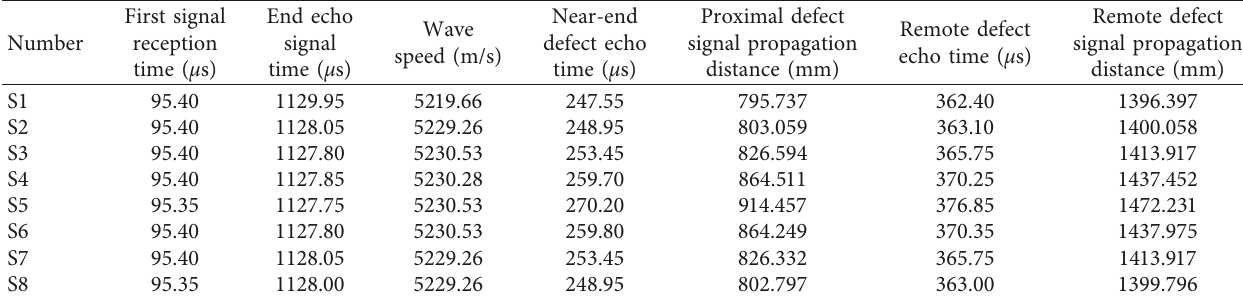
Table 5: Double-defect guided signal